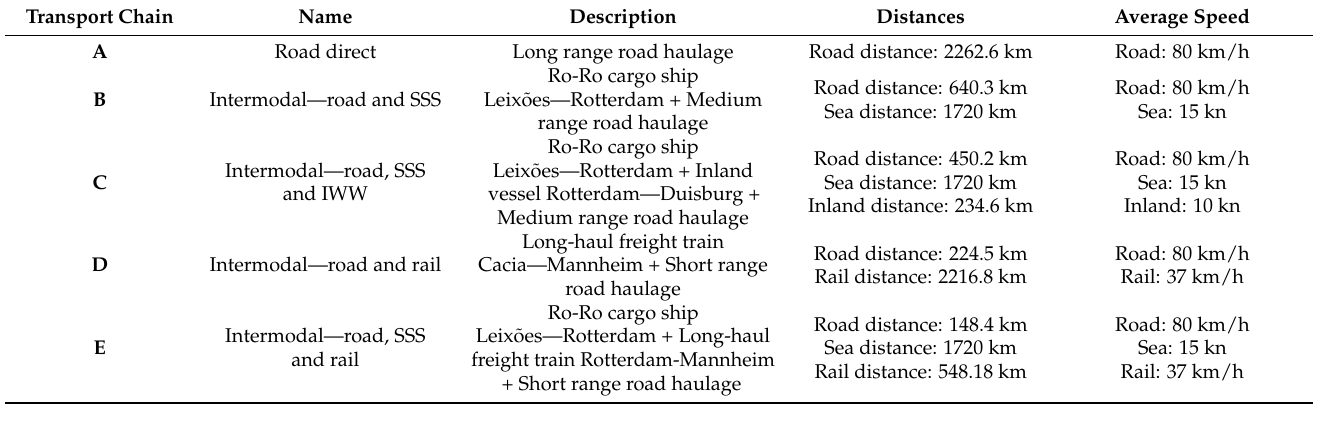
Table 8. General characteristics of different transport chains (A: unimodal; B–E: intermodal) between Porto and Stuttgart. Transport Chain